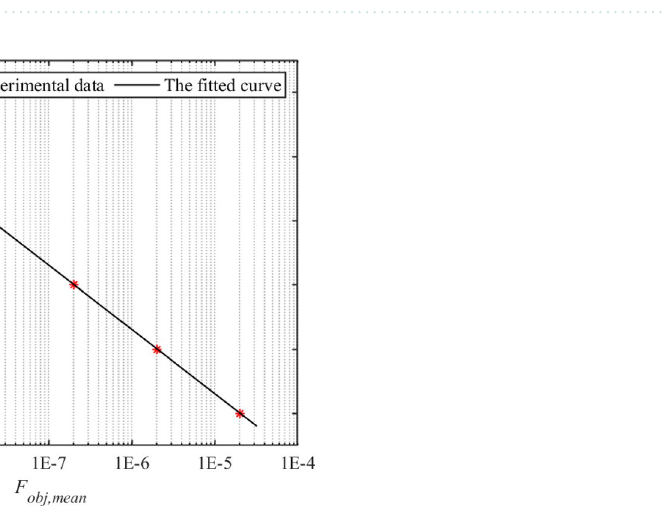
Figure 9. The reconstructed results with different SNR . ( a ) SNR = 65 dB. ( b ) SNR = 60 dB. ( c ) SNR = 55 dB. ( d ) SNR = 50 dB.